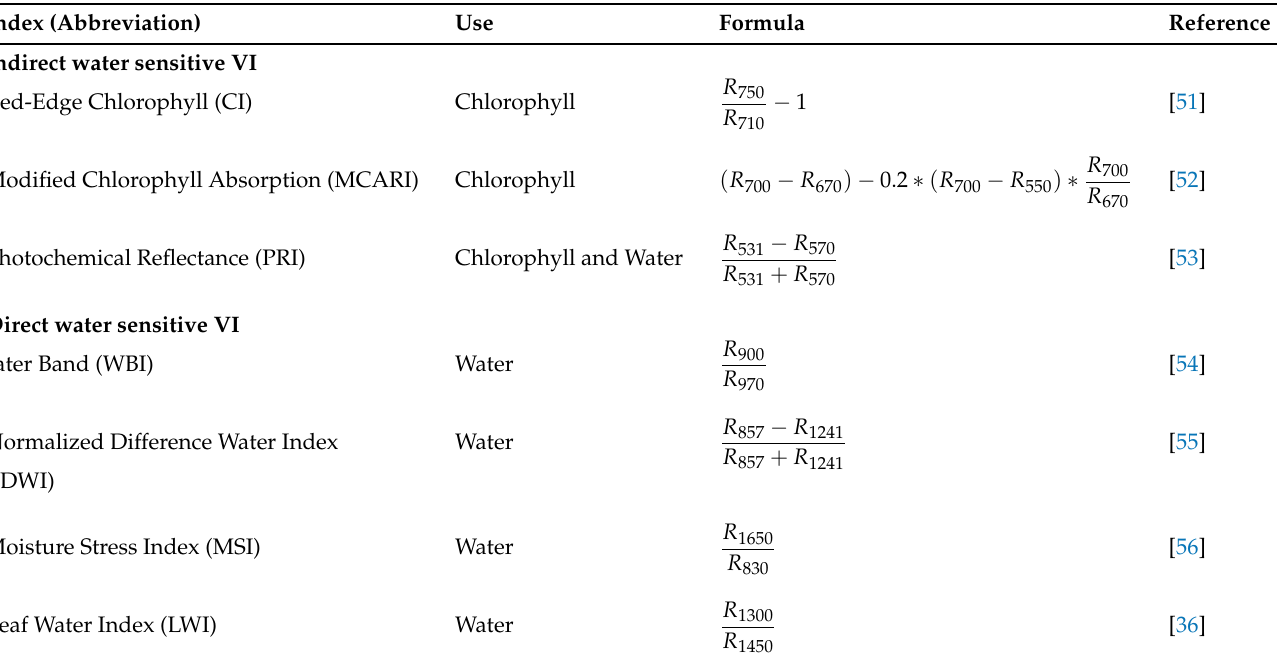
Table 5. Hyperspectral vegetation indices selected for this study and their formulas according to literature. Each wavelength is given in